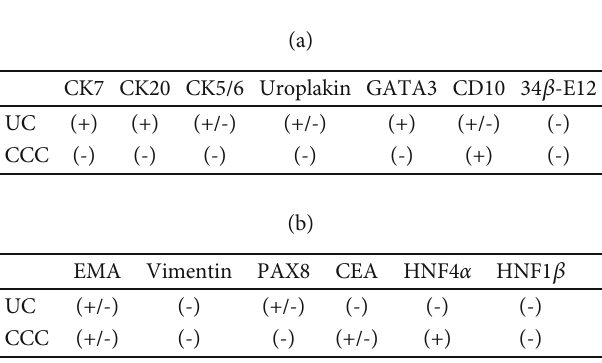
Figure 1: CT fi ndings. (a) Plain CT at diagnosis shows a right invasive ureteral tumor and no metastatic fi ndings ((a) arrow). (b) Plain CT after four course of chemotherapy shows the right ureteral tumor diminished in size after the therapy ((b) Table 1: Immunohistochemical results.